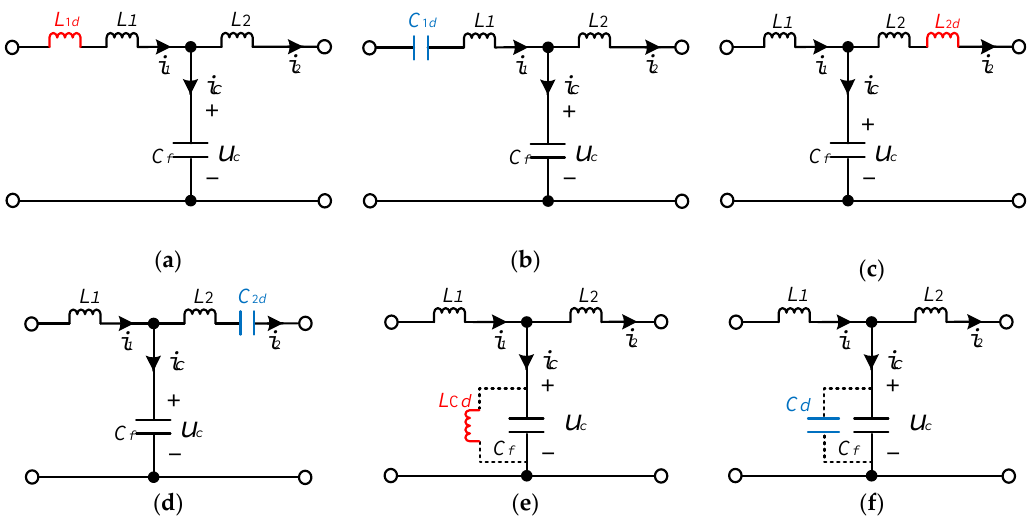
Figure 10. Virtual impedance equivalent circuits of actual LCL filter. ( a ) L 1 d ; ( b ) C 1 d ; ( c ) L 2 d ; ( d ) C 2 d ; ( e ) L Cd ; ( f ) C d